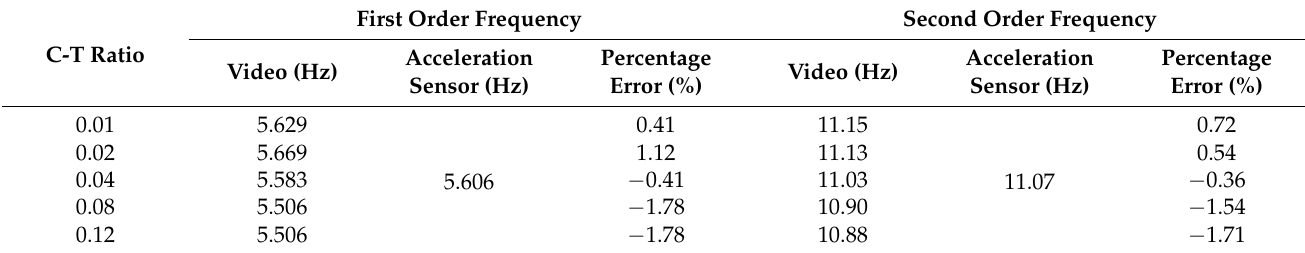
Figure 17. Time history diagrams and frequency domain diagrams of the vibrating cable in five continuous videos (top to bottom, C-T ratio is 0.01, 0.02, 0.04, 0.08, 0.12, respectively). Table 20. Comparison of cable vibration frequencies sampled by acceleration sensor and that derived from